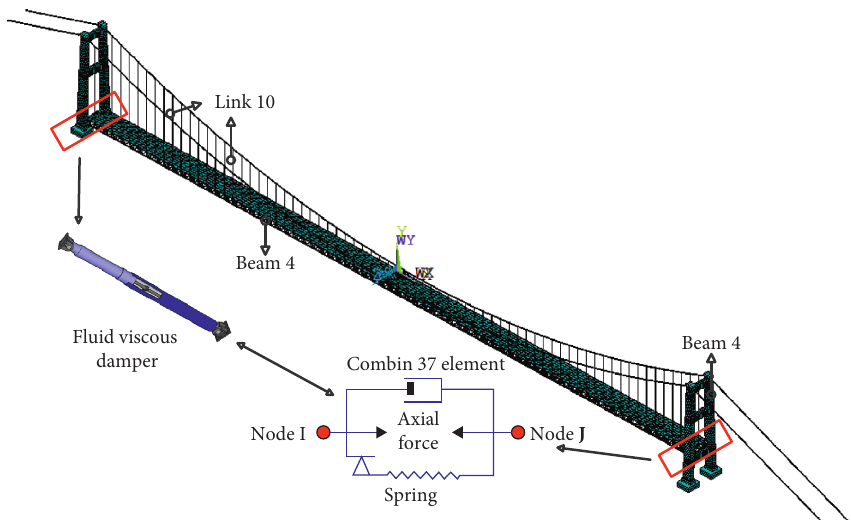
Figure 7: Information of bridge FE model.